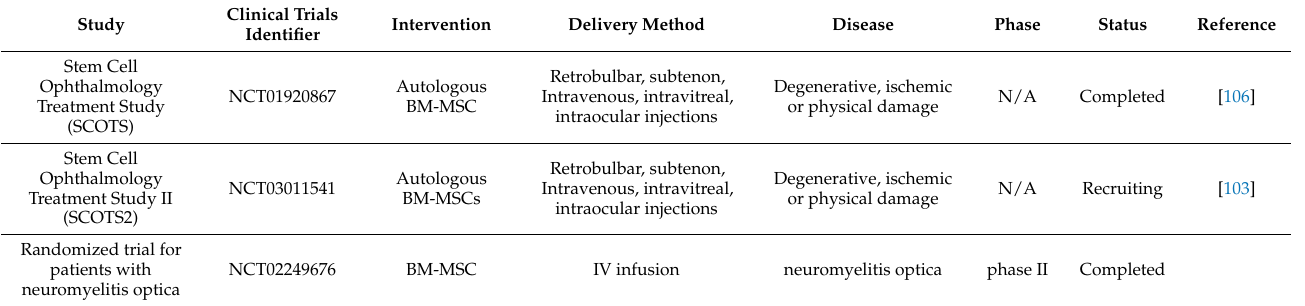
Table 2. Clinical Trials that utilized MSCs in ischemic